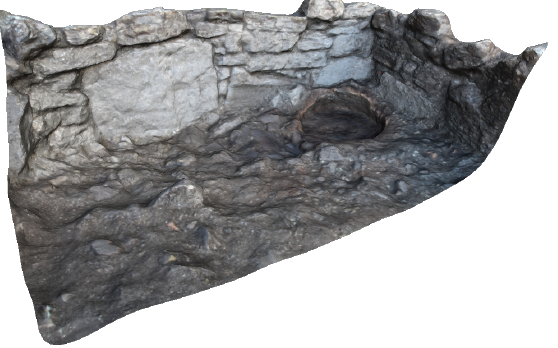
Figure 5. Image-based model of a medieval oven The time required on the field to achieve a single model was about 20 minutes, including the acquisition of approximately 60 images for each level and the measuring of Ground control points with total station.